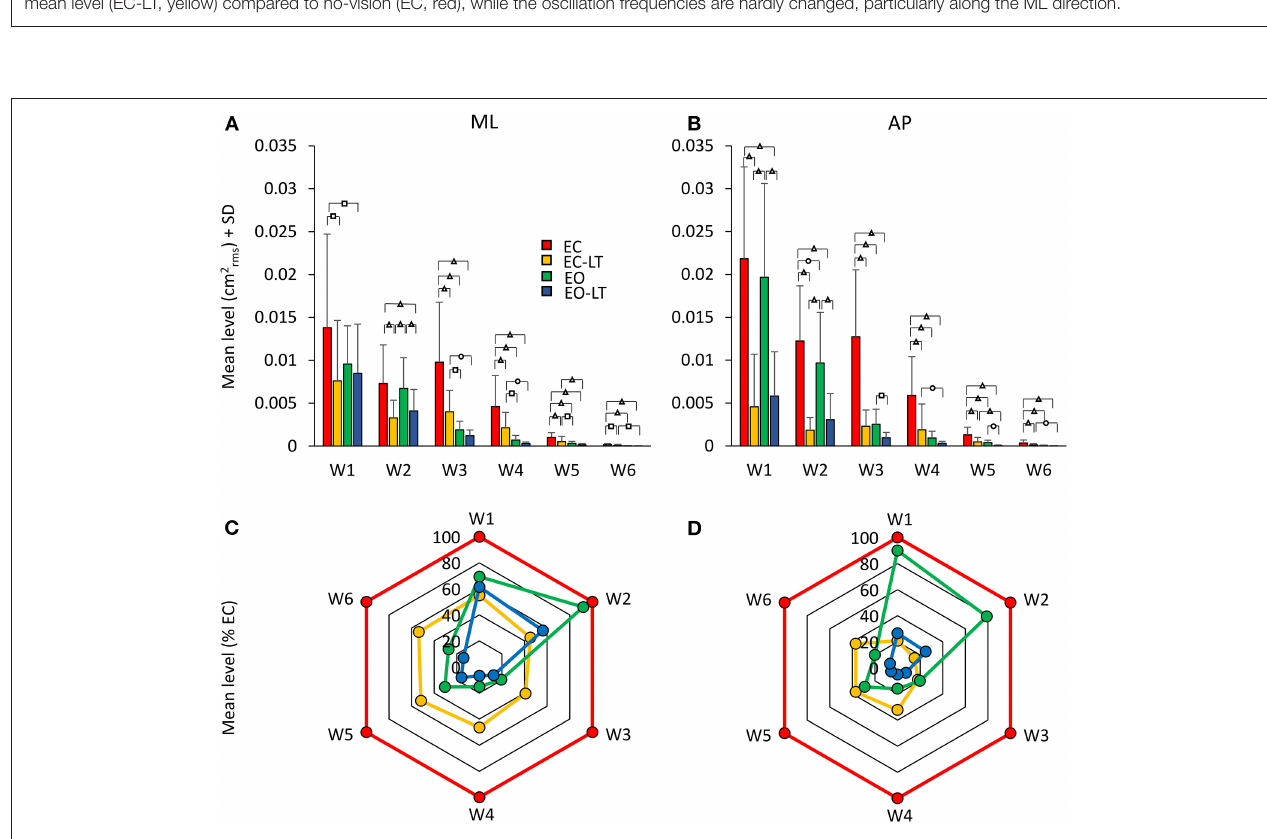
FIGURE 8 | Mean levels of the spectrum in the frequency windows (Ws) standing on foam. The mean level of the spectrum is irregularly distributed across the distinct Ws (A,B) . The EC condition (red bars) features a large mean level compared to the other sensory conditions in all the Ws, regardless of the ML or AP direction and of the progressive decrease in amplitude at the higher frequencies. The “stabilised” conditions show a non-uniform pattern depending on Ws and sensory conditions. EC-LT reduces the mean level in all the Ws in ML and more so in AP. Whereas, in ML and AP, EO (green) shows large mean levels at the low frequencies. Overall, the mean level at the highest frequencies is broadly reduced in all “stabilised” conditions. Distinct symbols indicate significant differences ( 2 p < 0.05; ◦ p < 0.01; 1 p < 0.001). A compact compendium of the percent reduction compared to EC (red outermost trace) in the mean level of the distinct frequency Ws under the EC-LT, EO, EO-LT conditions is given by the radar plots in (C) (ML) and (D) (AP).